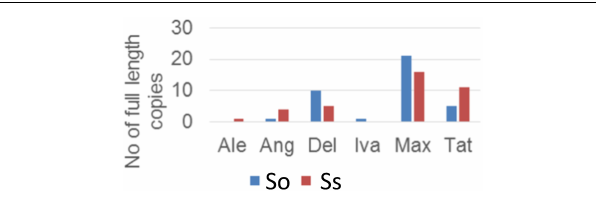
FIGURE 5 | Full-length LTR retrotransposon copies in So and Ss